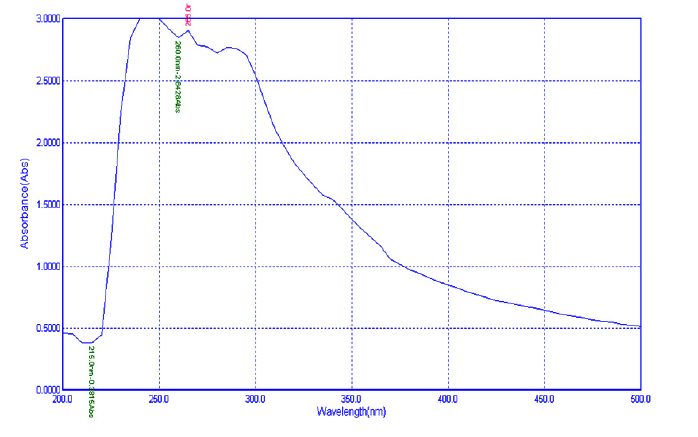
Fig. 5. UV-Visible study of chitin